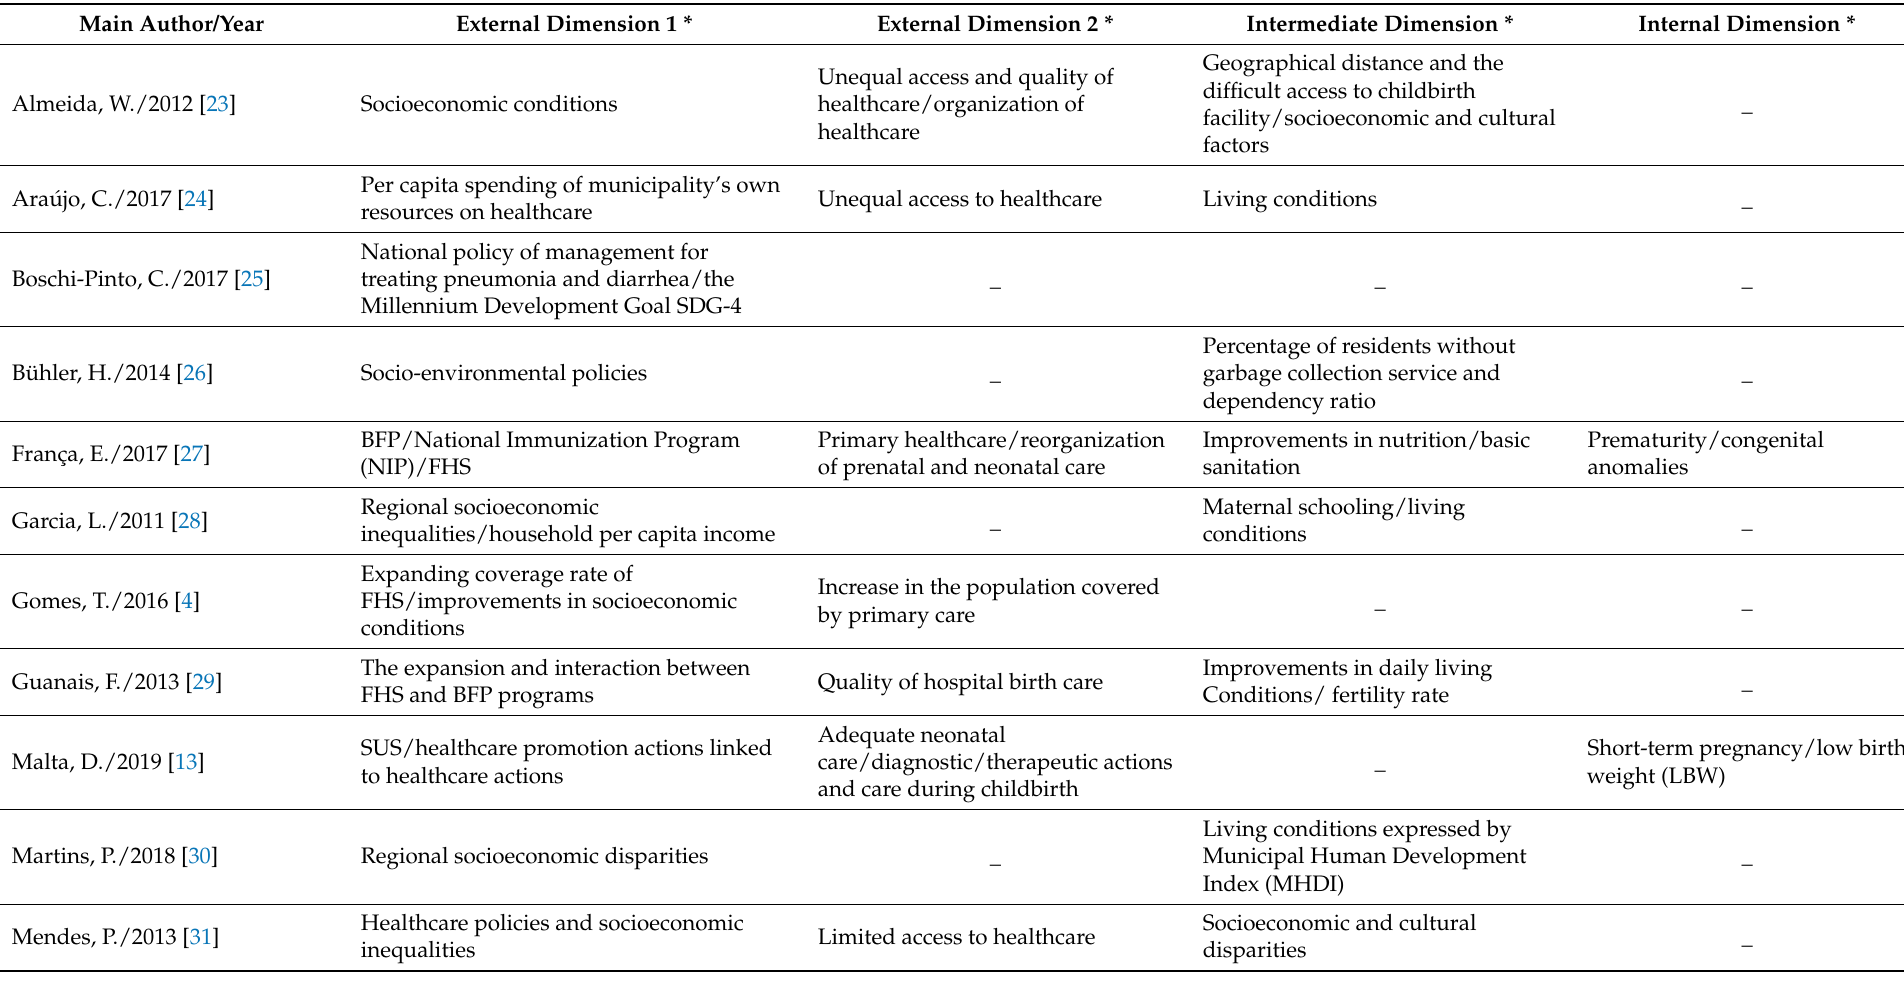
Table 4. The determinants of infant mortality in Brazil according to the four dimensions of the Conceptual Model of Health Capability